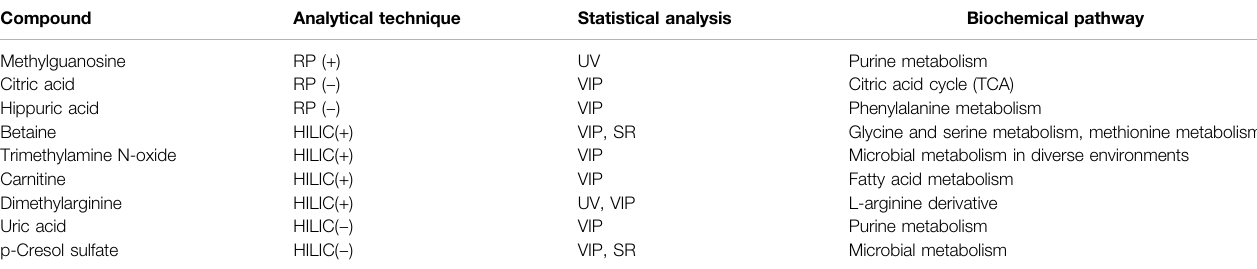
TABLE 3 | Statistically signi fi cant metabolites differentiating patients with normal and reduced estimated glomerular fi ltration rate (eGFR). Compound